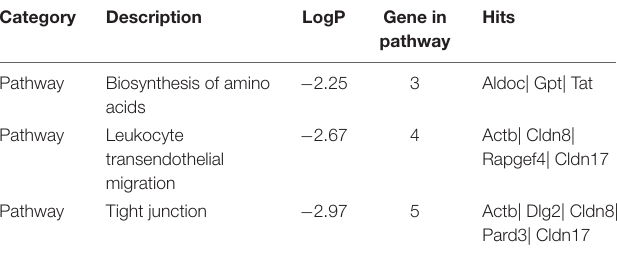
TABLE 4 | Enriched KEGG pathways of candidate genes.